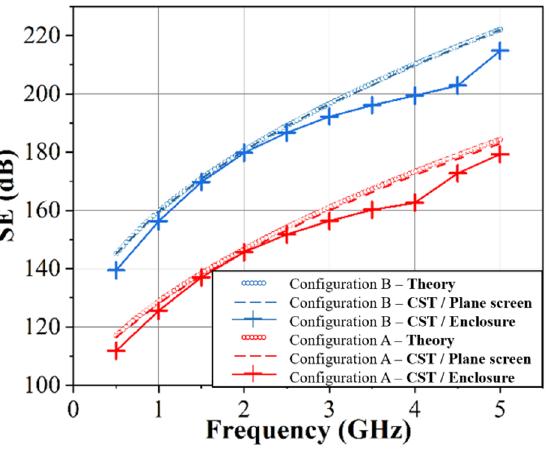
Figure 15. Comparison of SE obtained from simulation between theory, the CST plane screen, and the CST finite enclosure (configurations A and B).